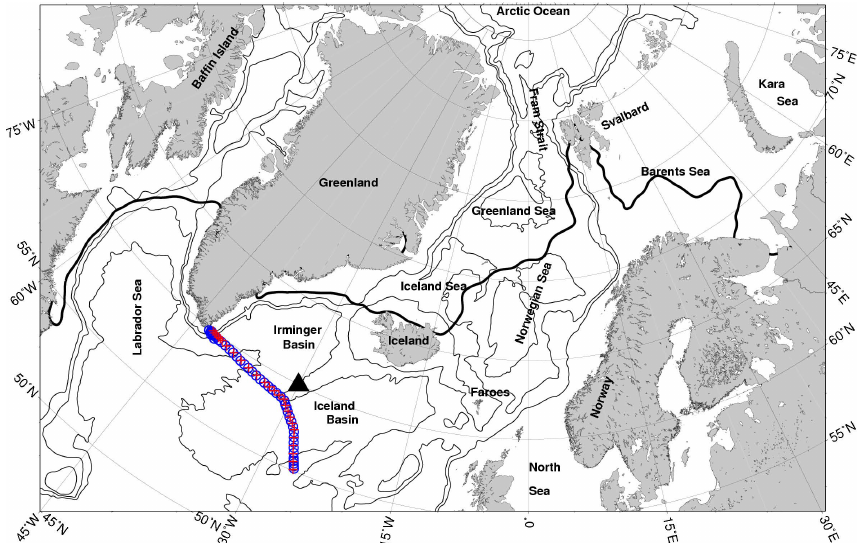
Fig. 1a. Map of subpolar North Atlantic and Nordic Seas. The black thick line is the Arctic Front represented by the 4 ◦ C isotherm (from GPOMZ 1948–2009 climatology) and the thinner lines are the bathymetry contours (500, 1500, and 3000m). The black triangle indicates the site chosen for the 1-D ecosystem-carbon model. The blue circles (1994) and red crosses (2004) indicate the location of the two repeat CARINA transects.